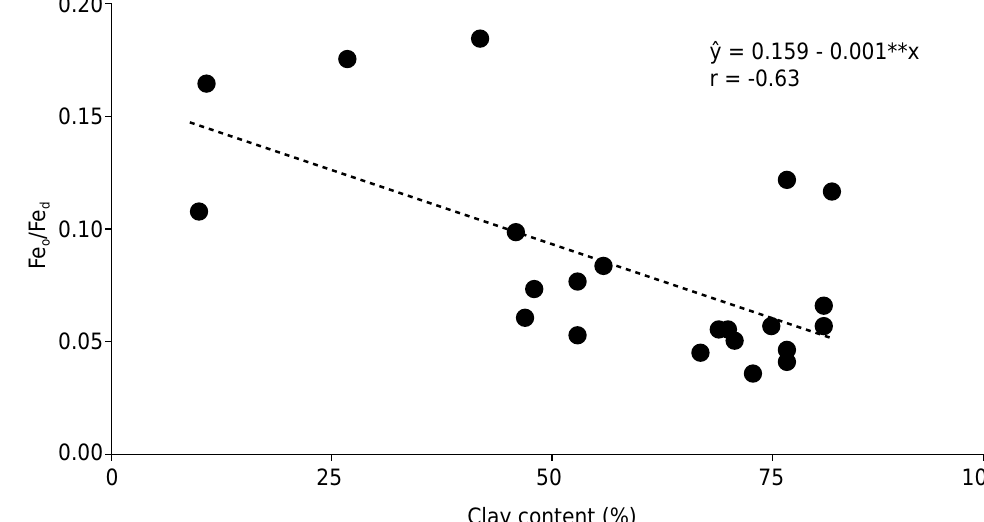
Figure 4. Ratio between low and high crystallinity Fe oxyhydroxides (Fe o /Fe d ) and clay content of the soils. ** : significant at 1 % by the F